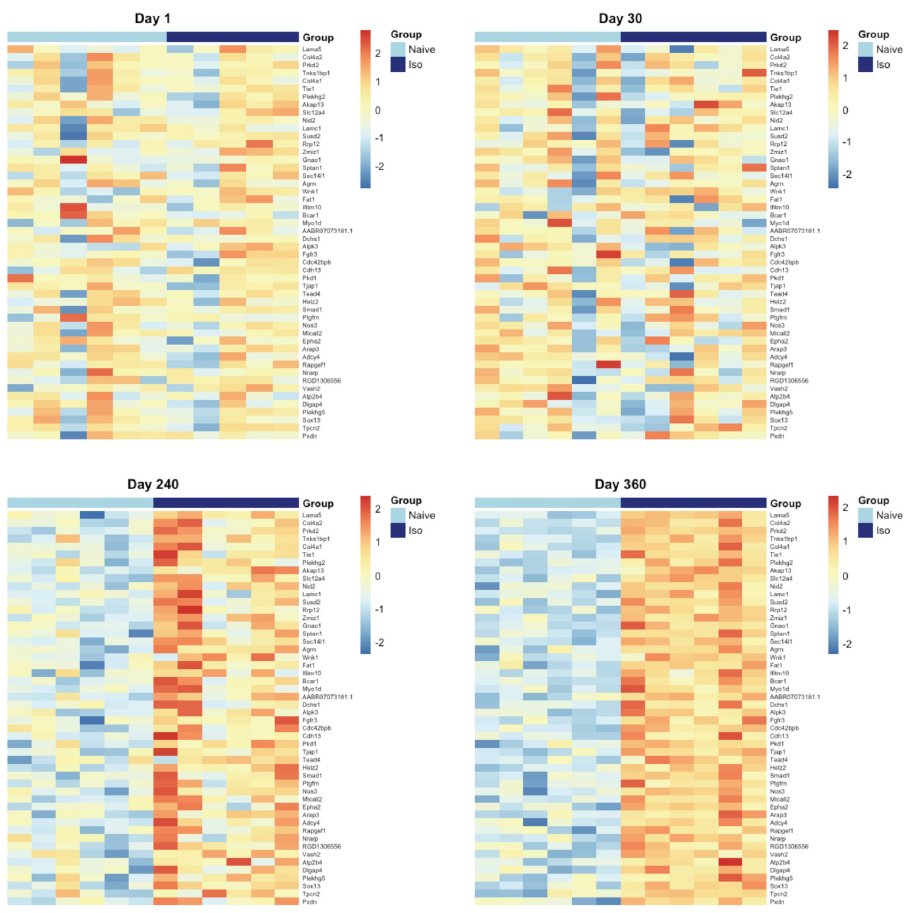
Fig 13. Heatmaps of the top 50 consistently up-regulated DEG that were identified at the later timepoints. Heatmaps were generated for top 50 consistently up-regulated DEG according to FDR at Day 360. Normalized expression levels were used and standardized within each gene. For the group scale, light blue represents na ï ve group samples and dark blue represents ISO group samples. Groups of rats exposed to air (na ï ve, n = 6/each timepoint group) or ISO (n = 5/Day 1 group, and n = 6/Day 30, 240, and 360 groups) were